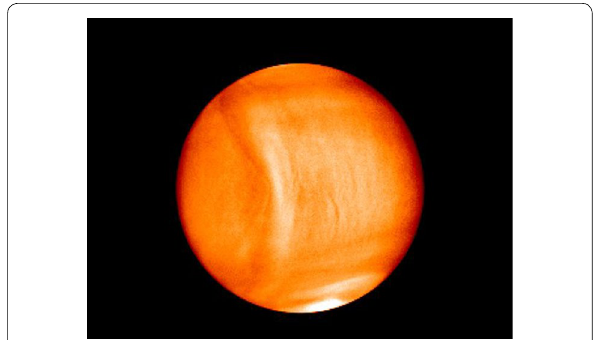
Fig. 14 A 10‑μm image taken by LIR (Longwave InfraRed) camera at 05:26 on December 07, 2015, at a distance of 73,000 km with a sub‑spacecraft latitude of 7° and a longitude of 95°. The main Bow − is seen near the center at around a longitude of 85° with a latitudinal extent of almost 10,000 km